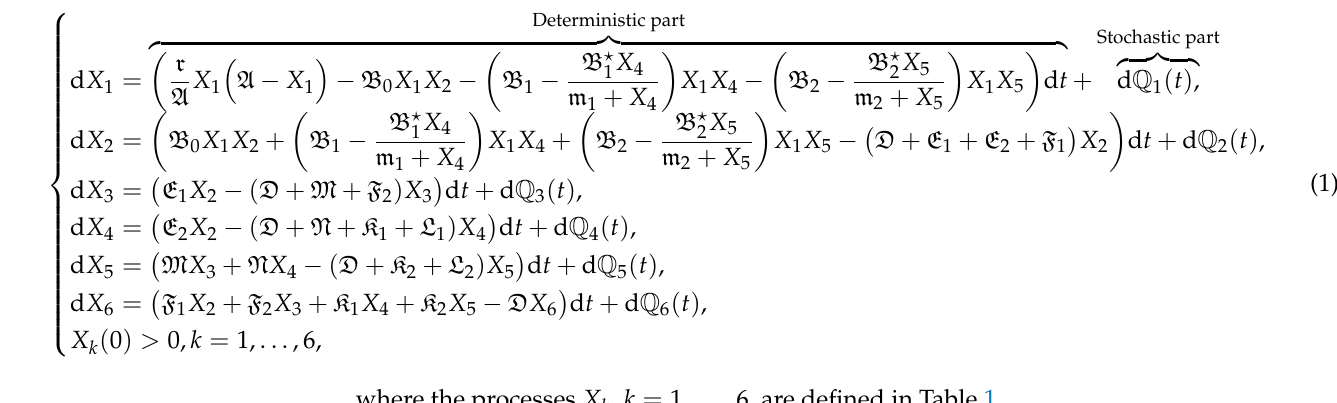
− 1 1 days 1 1 million − 1 1 and X 2 days − 1 − 1 1 and X 5 days